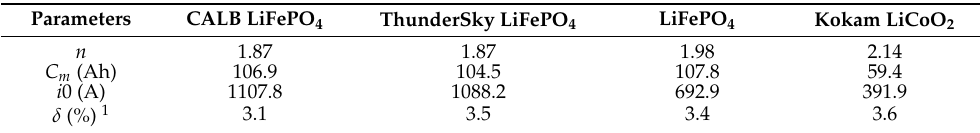
Table 2. Optimal values of parameters for generalized Peukert’s Equation (6).